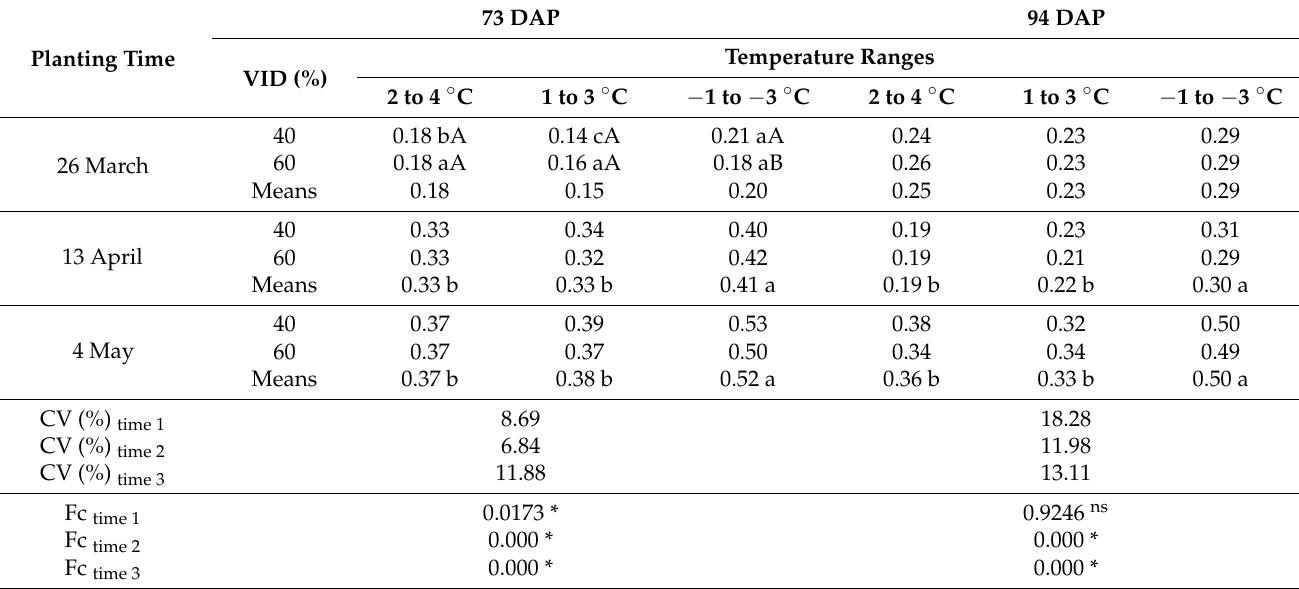
Table 5. Bulbar ratios of garlic plants at 73 and 94 days after planting (DAP), under different temperatures ranges and visual index of overcoming dormancy (VID).